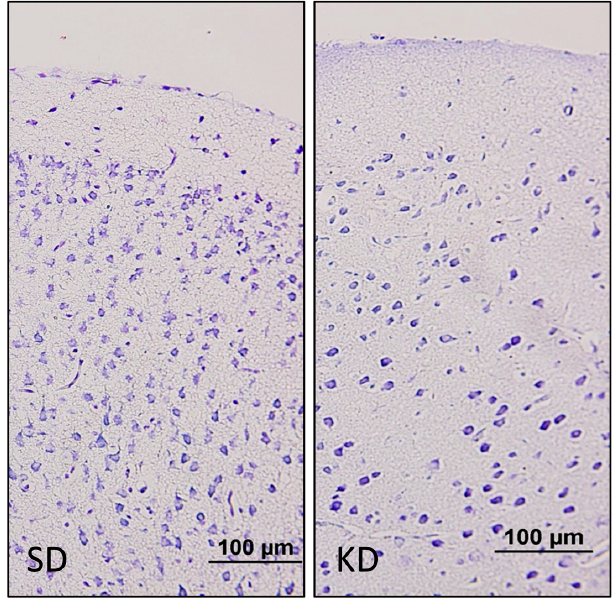
Figure 2. Cresyl violet staining of the prefrontal cortex. The neuronal density was lower in the KD group when compared to the SD group at PN11. (20×).